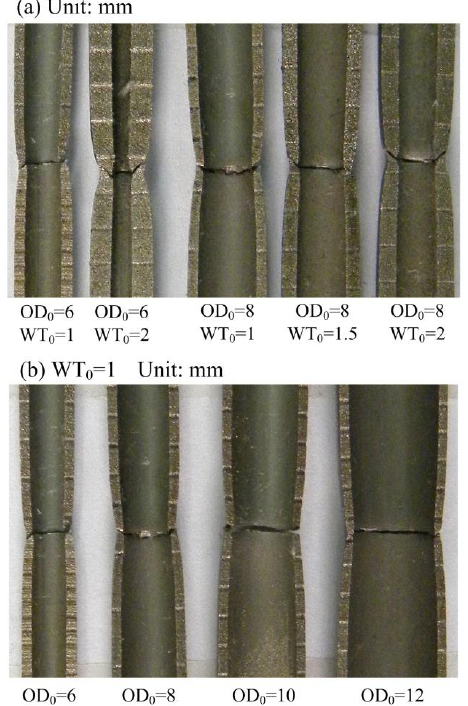
Figure 3. Geometries of tube walls at fracture area with ( a ) different wall thicknesses, and ( b ) different outer diameters.